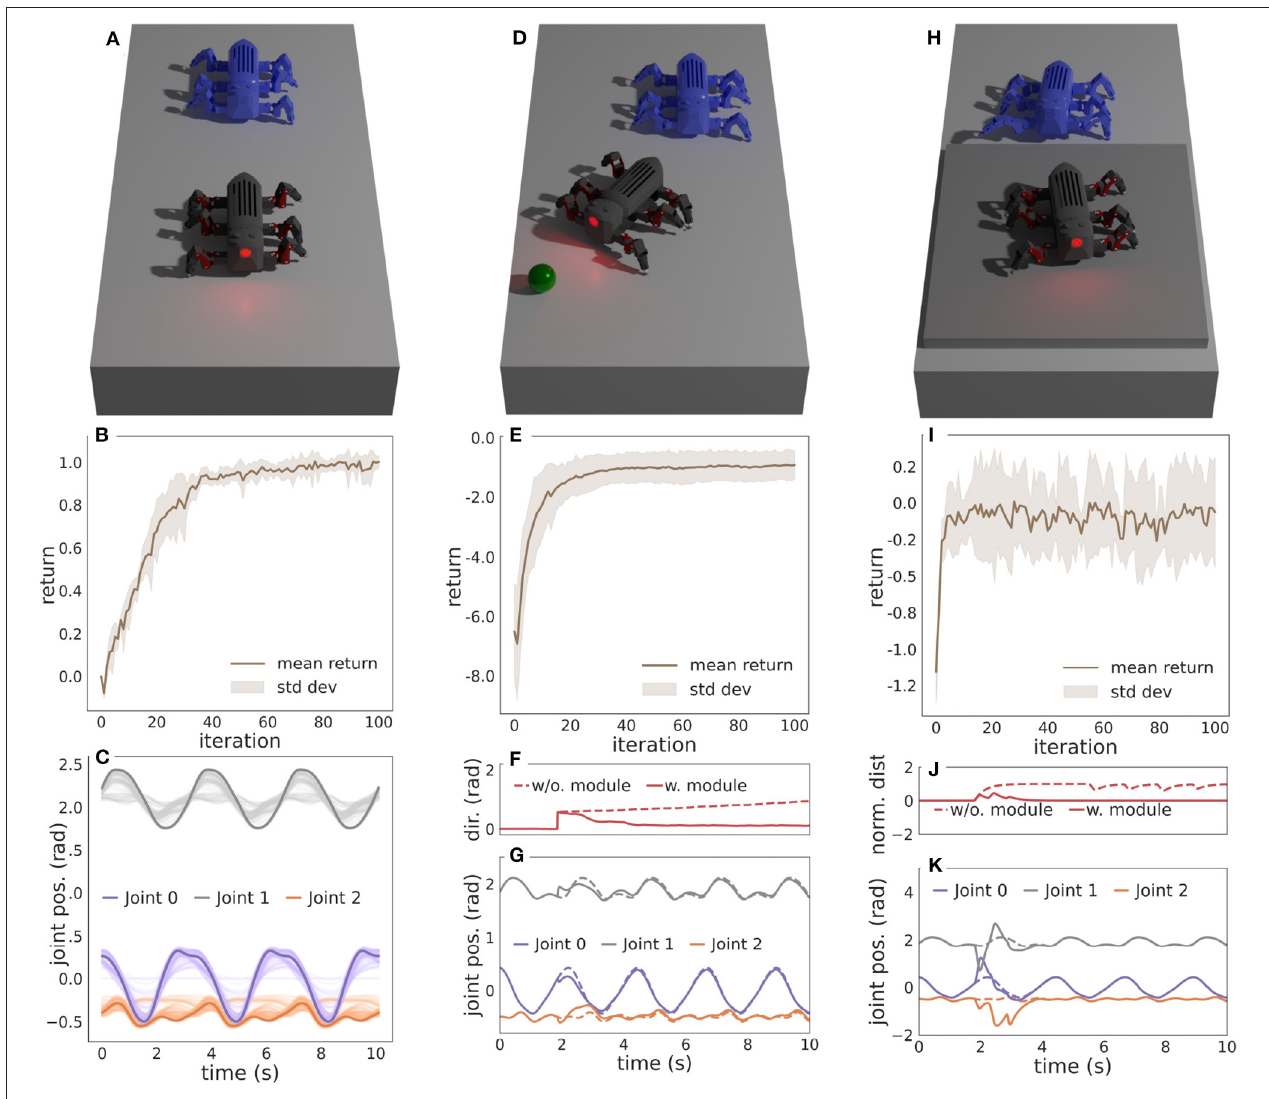
FIGURE 2 | (A) The simulated environment and learned open-loop behavior for walking straight. (B) The mean reward and standard deviation per iteration. (C) The motor patterns during learning for a single leg. The solid lines are converged patterns, and the transparent lines are intermediate patterns during learning. (D) The simulated environment and learned closed-loop sub-behavior module for steering. A sphere specifying the desired heading direction will spawn after 2 s. (E) The mean reward and standard deviation per iteration. (F) The heading direction error with and without the sub-behavior module. (G) The learned motor patterns for a single leg with and without the sub-behavior module enabled. (H) The simulated environment and learned closed-loop sub-behavior module for climbing steps. (I) The mean reward and standard deviation per iteration. (J) The normalized optic distance sensor feedback with and without the sub-behavior module enabled. (K) The learned motor patterns for a single leg with and without the sub-behavior module enabled. For (A,D,H) the blue MORF shows an earlier time-step of the sub-behavior. Modified from Thor and Manoonpong (2021).